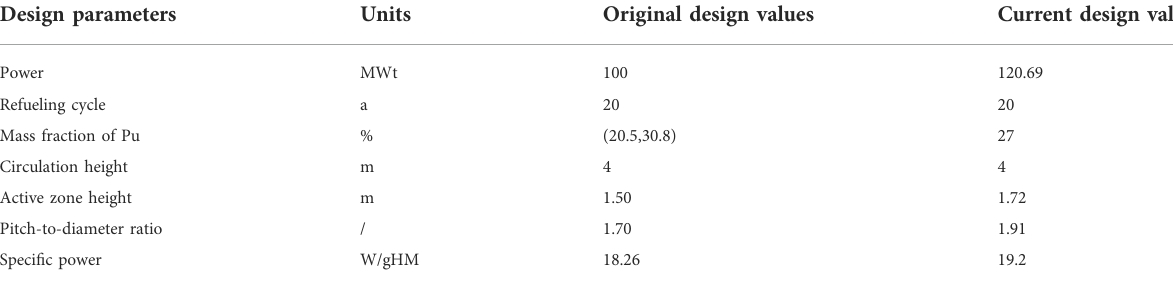
TABLE 2 Necessary parameters for maximizing the reactor power.